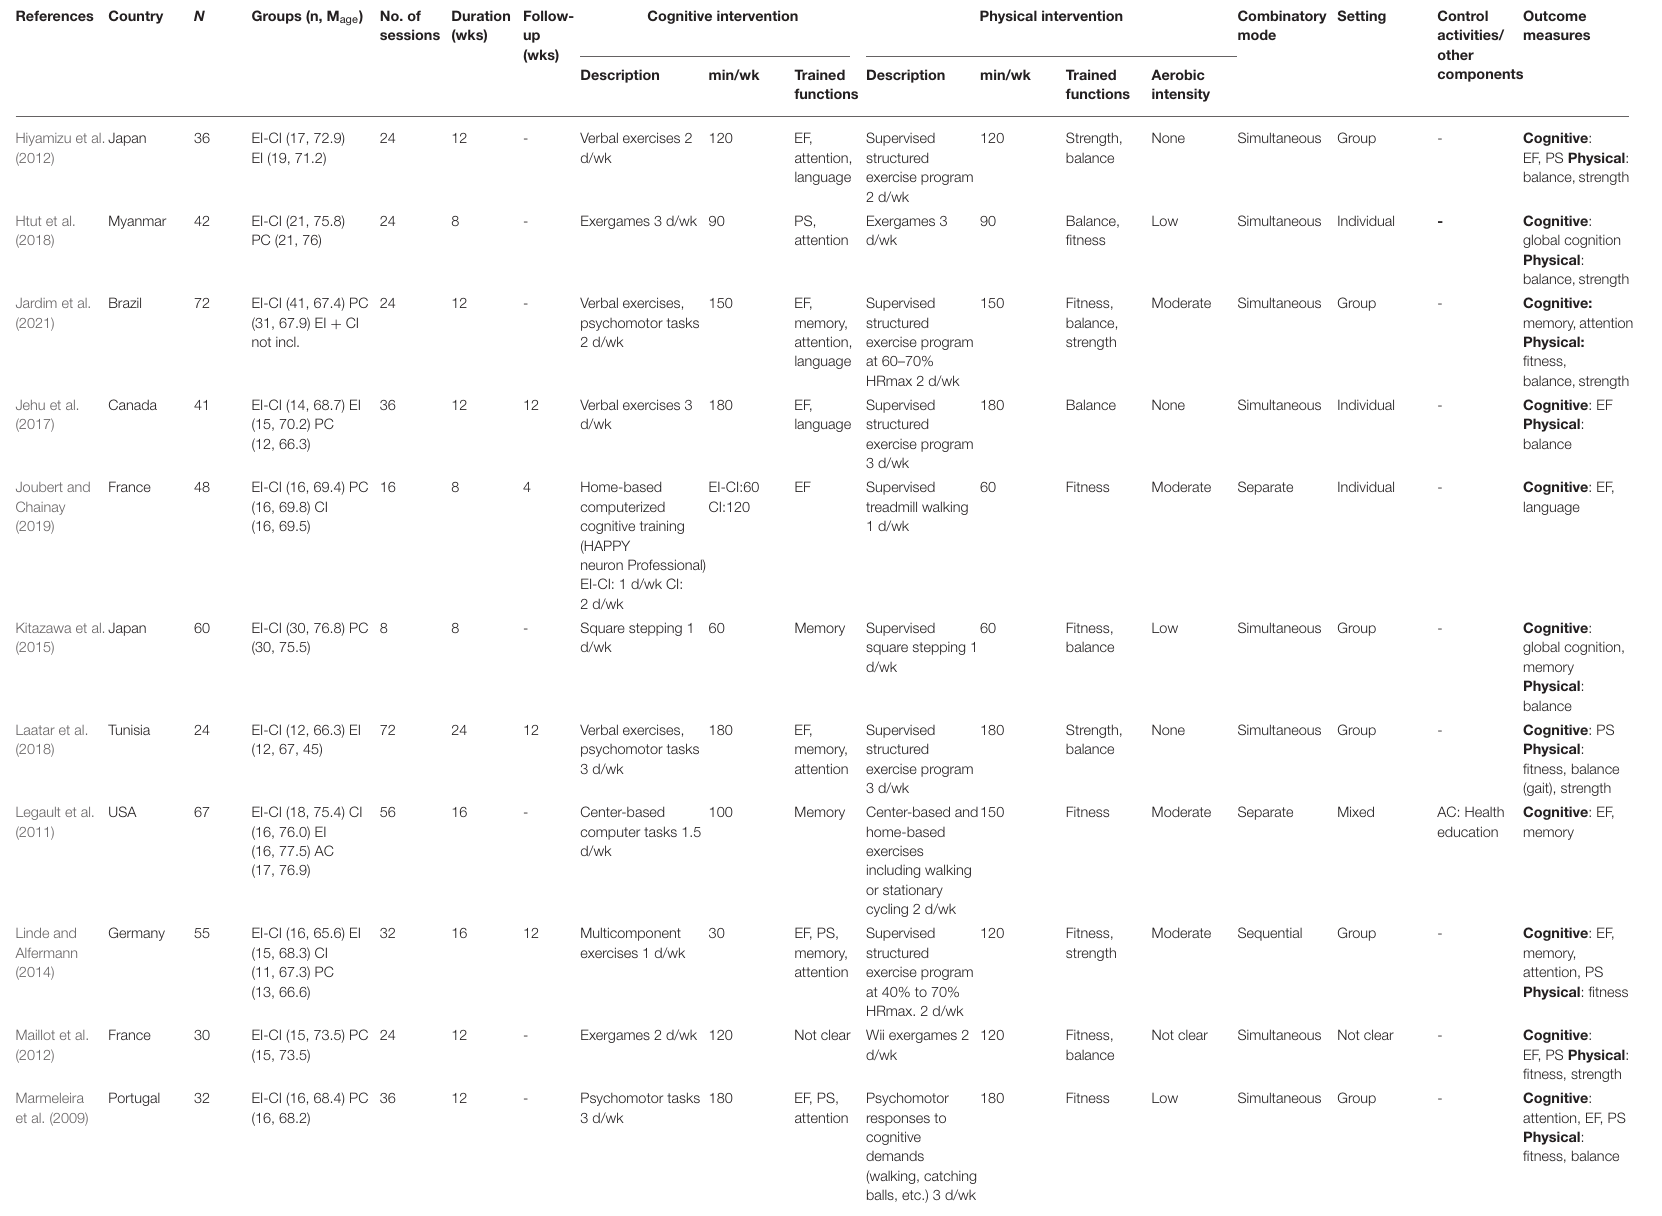
Marmeleira EF, PS,